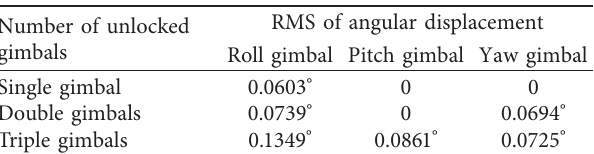
Figure 16: Angular displacements of (a) base plate, (b) roll gimbal, (c) pitch gimbal, and (d) yaw gimbal with three unlocked gimbals. Table 2: Attitude stabilization precision with different numbers of unlocked